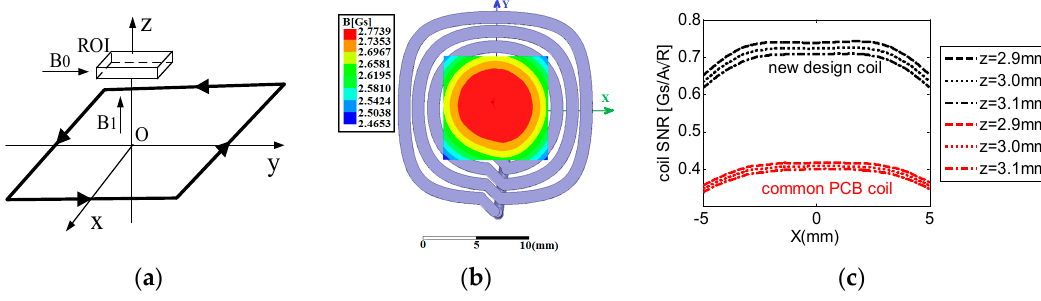
Figure 4. ( a ) Structure of the uniplanar RF coil for unilateral magnetic resonance imaging (UMRI) sensor. ( b ) A solution of the current wire pattern of the coil and simulation result. The simulation is performed using Maxwell 3D software for the UMRI sensor. The central plane of ROI is 3 mm above the current source plane. ( c ) Simulation results of coil SNR. Comparison of the coil SNR at y = 0 in the upper, central, and lower planes of the ROI between the designed and common PCB coils.